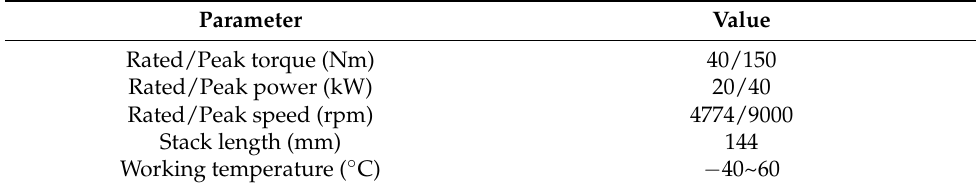
Table 1. Detailed parameters of the motor.